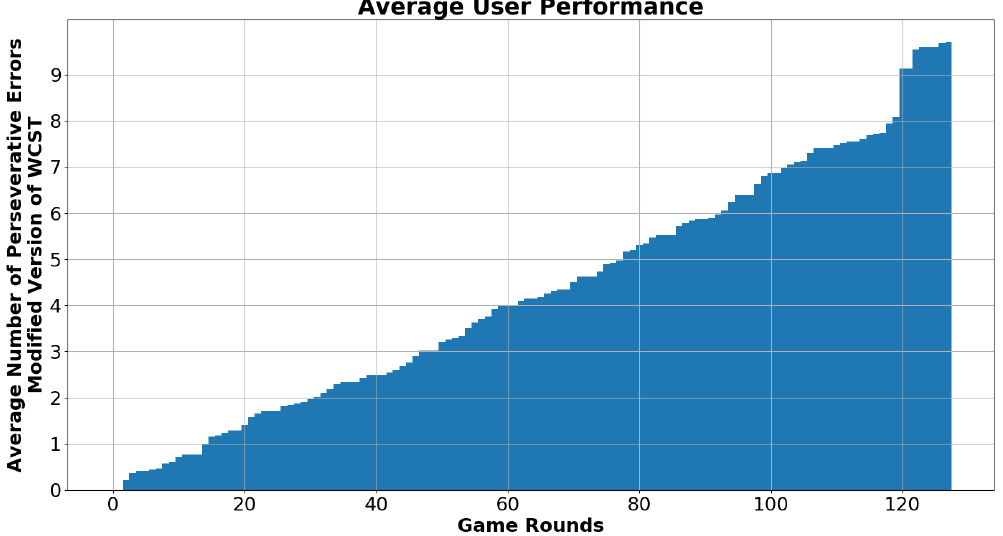
Figure 9. Average number of perseverative errors when playing V1 and V2 versions of